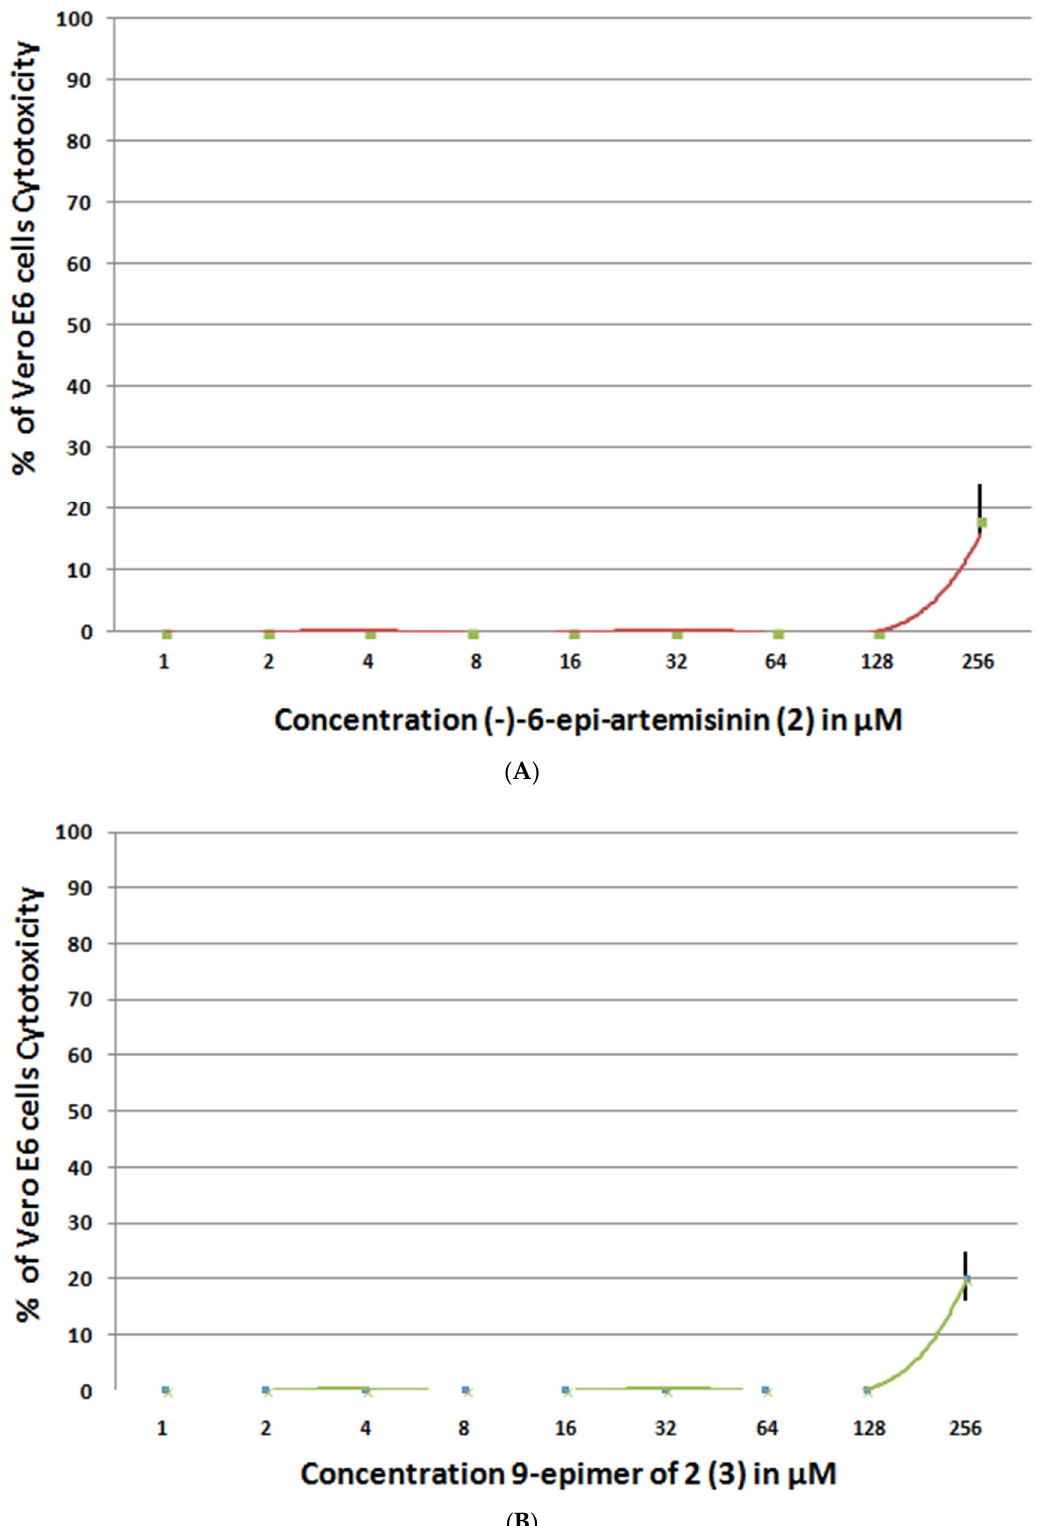
Figure 9. The percentage of cytotoxicity of ( − )-6-epi-artemisinin ( 2 ) against Vero E6 cells with ( A ) CC 50 > 250 μ M and 9 epimer of 2 ( 3 ) with ( B ) CC 50 > 200 μ M.